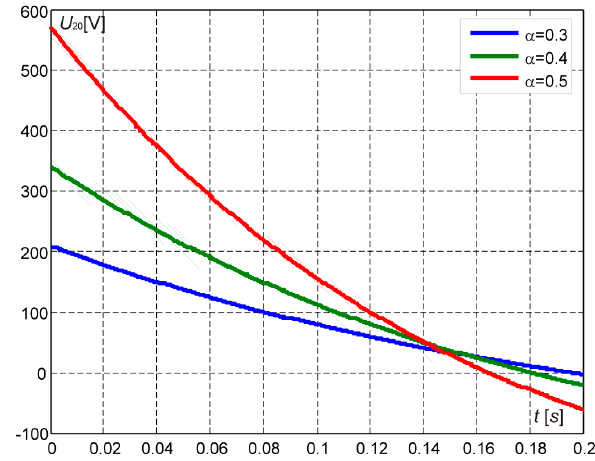
Figure 13. Voltage curves at the output of a two-port network with rectangular-pulse forcing for t ≥ t 0 and α = 0.95, 0.9, 0.8, 0.75.